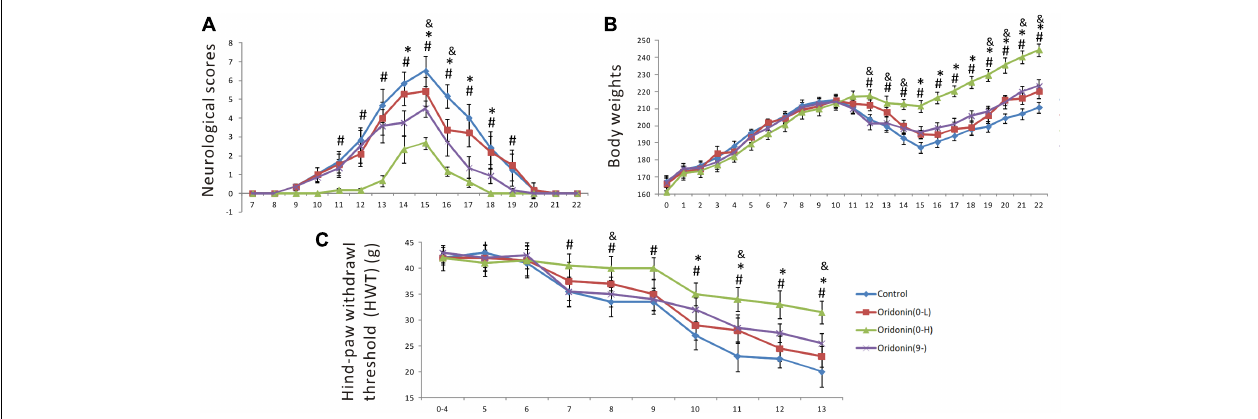
FIGURE 2 | Preventive and therapeutic Oridonin treatments attenuated neurological disease severity, shortened disease duration and suppressed mechanical allodynia in EAN rats. EAN rats ( n = 6) were orally administrated daily with Oridonin (7 or 20 mg/kg in CMC) or CMC alone (same volume), since Day 0 as preventive or since Day 9 (first neurological sign occurred) as therapeutic treatment. Neurological scores and body weights were recorded every day post-immunization. (A) Both preventive and therapeutic Oridonin treatments decreased neurological severity of EAN and shortened EAN duration. (B) Meanwhile, the reduction of body weights, which is also a characteristic sign of EAN, was significantly ameliorated by both therapeutic and preventive treatments with Oridonin. (C) The another characteristic neurological sign of EAN, mechanical allodynia, defined as reduction of HWT, was observed as early as Day 7 up to the end of the experiment (Day 13) in the control group. Either therapeutic or preventive treatment with Oridonin at high or low doses significantly restored the reductions. Significant differences of HWT among control, Oridonin therapeutic and preventive groups were confirmed. Finally, repeated ANOVA assays indicated significant difference between all the three groups, in neurological scores, body weight time courses and HWT. ∗ p < 0.05 comparison of the preventive treatment group to the control group, & p < 0.05 comparison of the preventive treatment group at 7 mg/kg to the control group, # p < 0.05 comparison of the therapeutic treatment group to the control group, n =